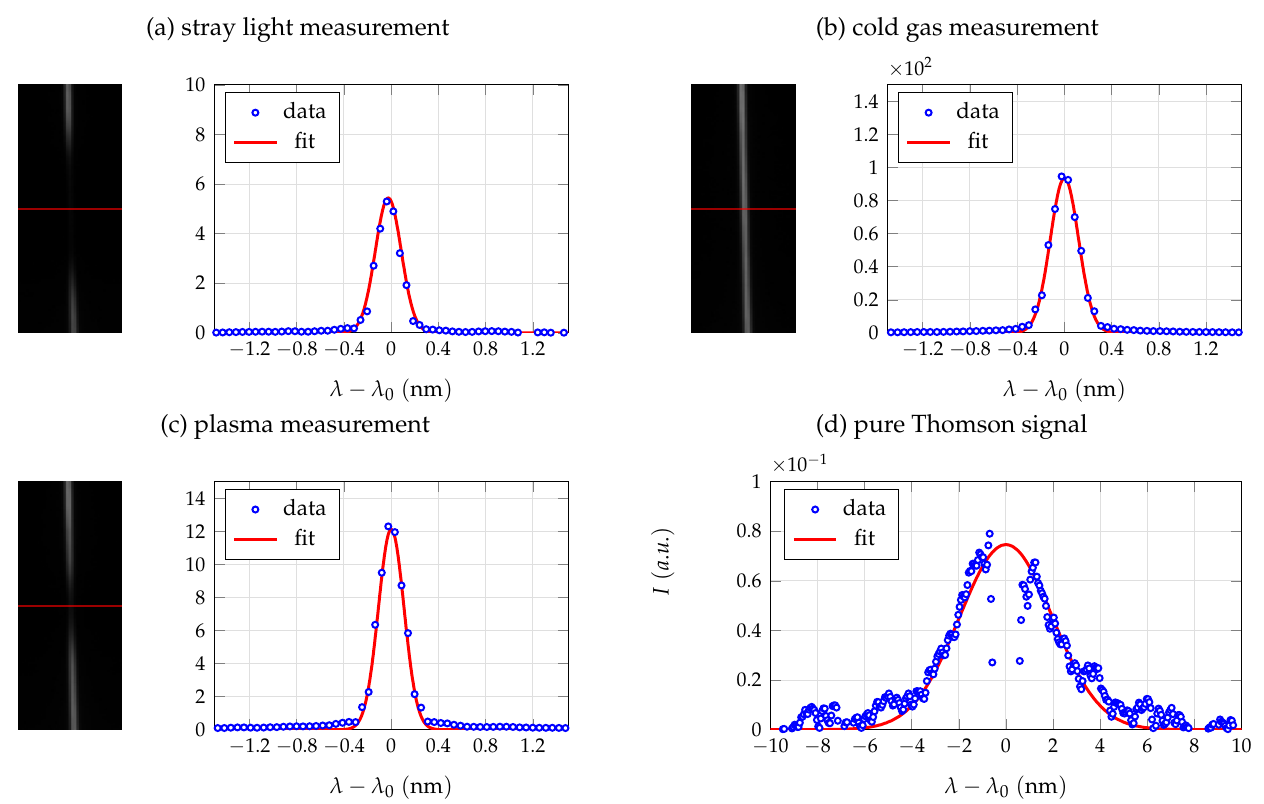
Figure 4. Average images of (a) stray light, (b) cold gas, and (c) plasma measurements obtained after pre-processing, and the corresponding spectral profiles for the marked pixel line used to determine the plasma parameters. The pure Thomson scattering signal extracted from these spectral profiles is shown in diagram (d).